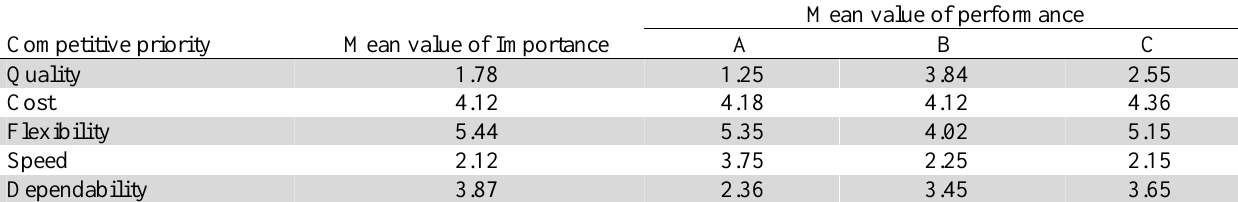
Mean Values of Importance and Performance